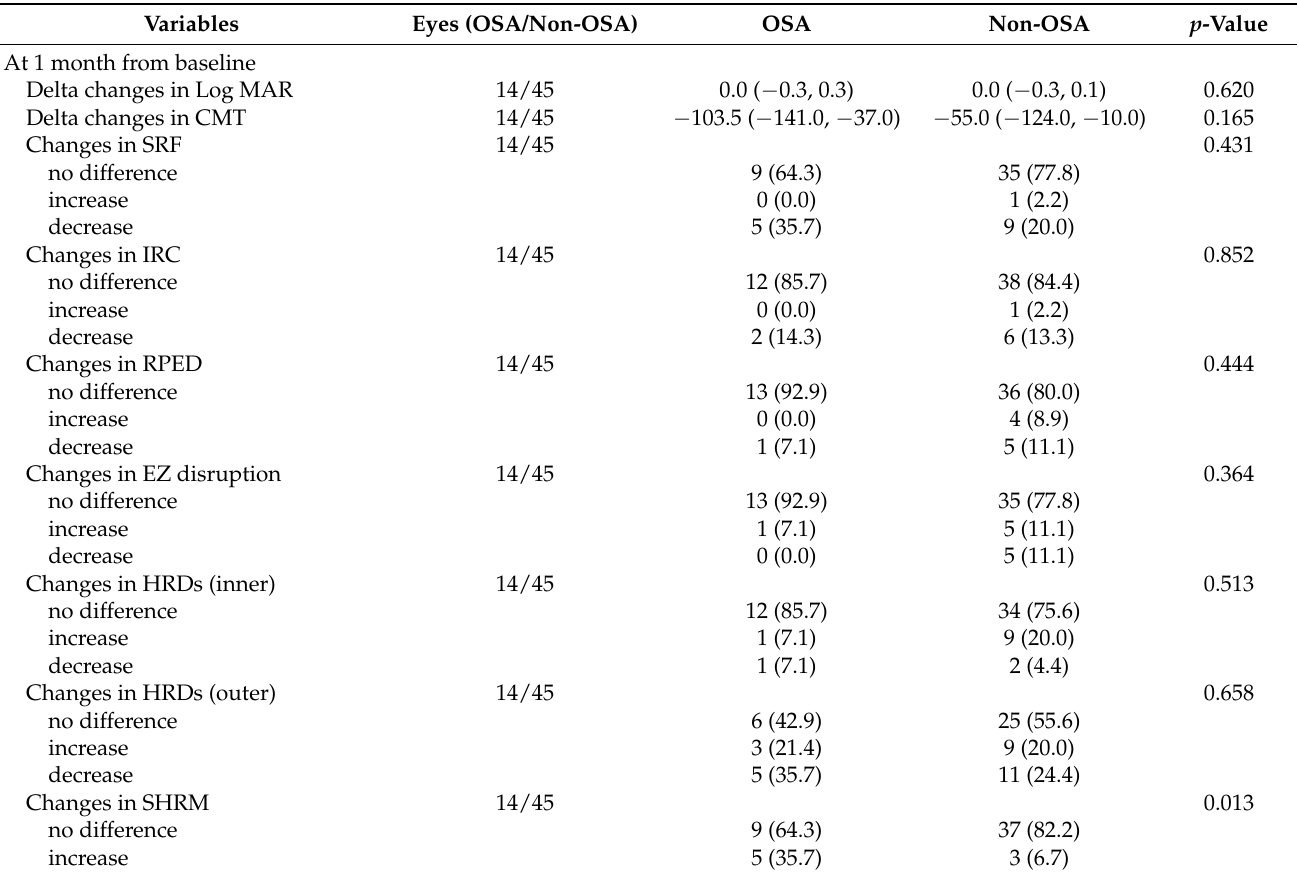
Table 3. Changes in functional and anatomical outcomes after anti-VEGF